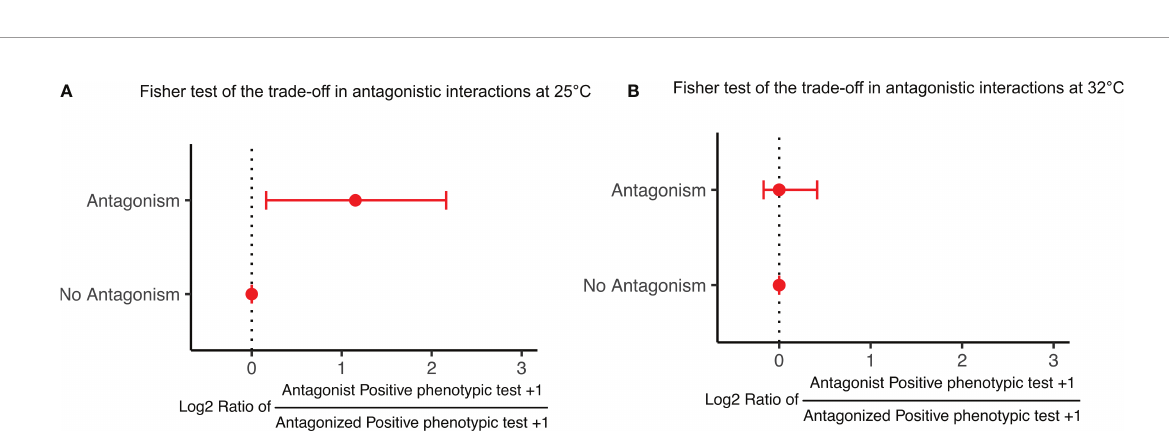
FIGURE 4 | The correlation between inhibition probability and the phylogenetic (A, B) and phenotypic distances (C, D) at 25°C (A, C) and 32°C (B, D) . The probability of inhibition increased with decreasing phylogenetic distance. The red line is a logistic regression, and the gray shaded area denotes the 95% con fi dence interval ( A , 25°C, P = 0.0284, pseudo-R 2 = 0.021; B , 32°C, P = 0.020; pseudo-R 2 = 0.021; C , 25°C, P = 0.891; D , 32°C, P = 0.775, n = 496).